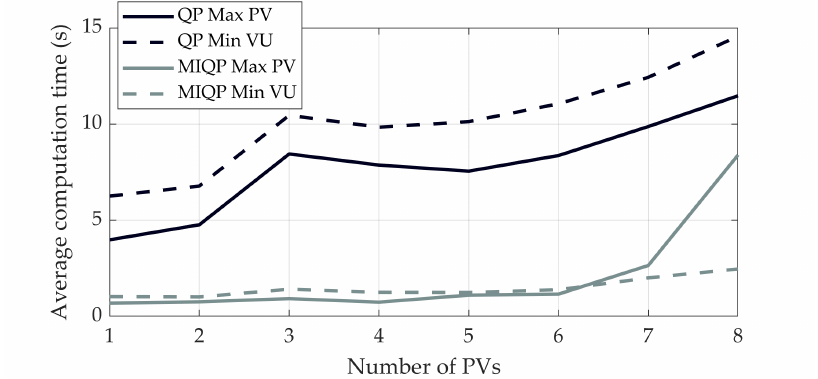
Figure 13. Average computation